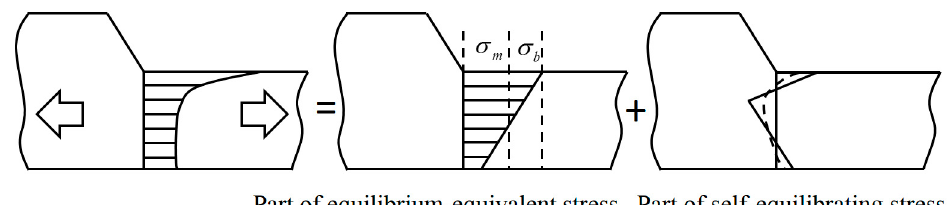
Figure 1. Decomposition of through-thickness stress.